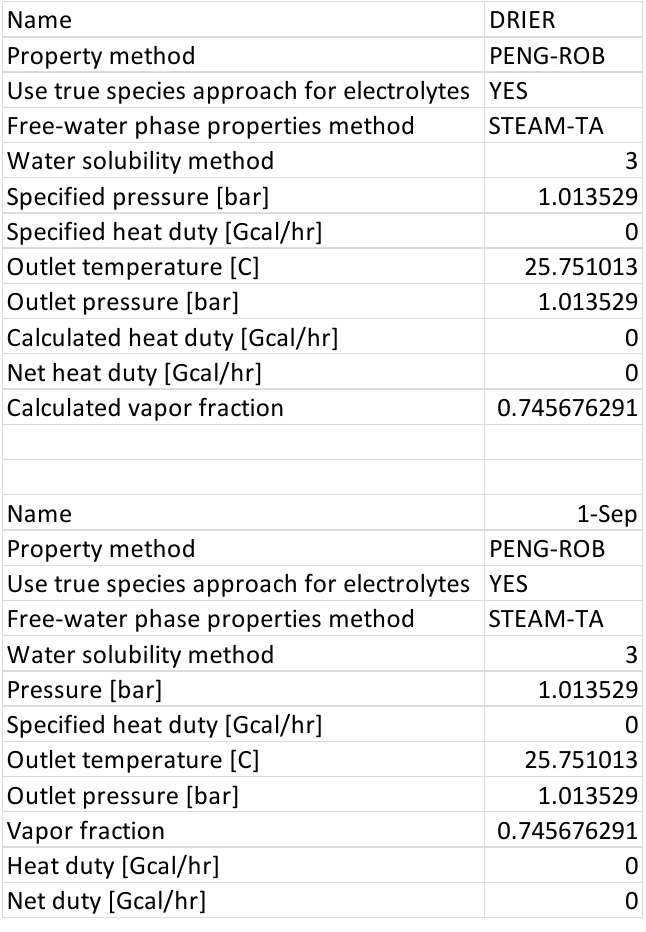
Figure A11. Gasification drier and separator results.